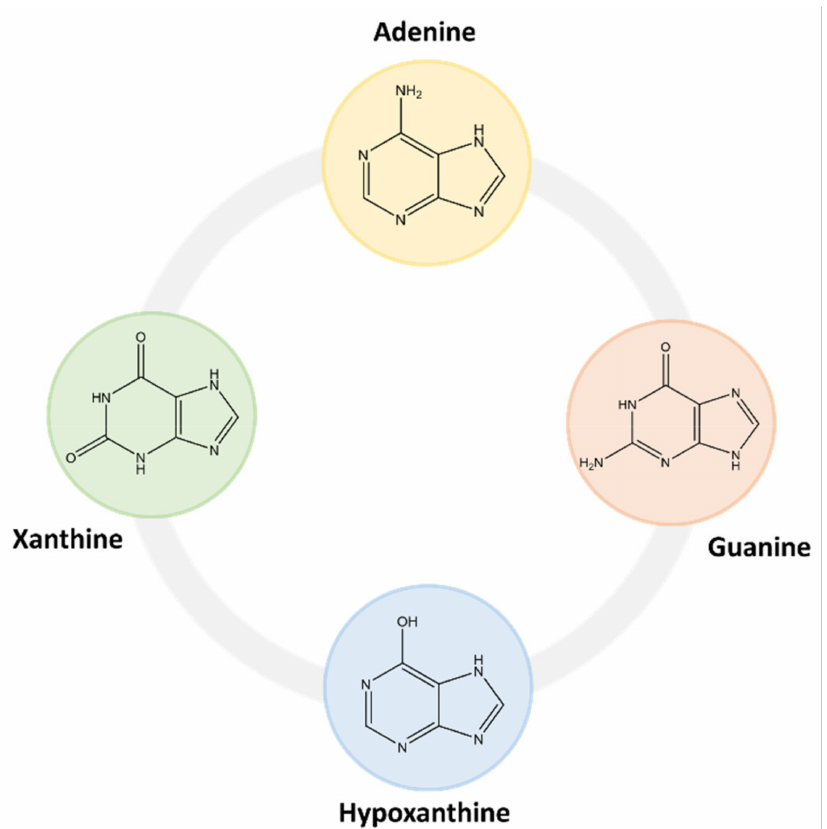
Figure 4. Universe of purine compounds and their chemical